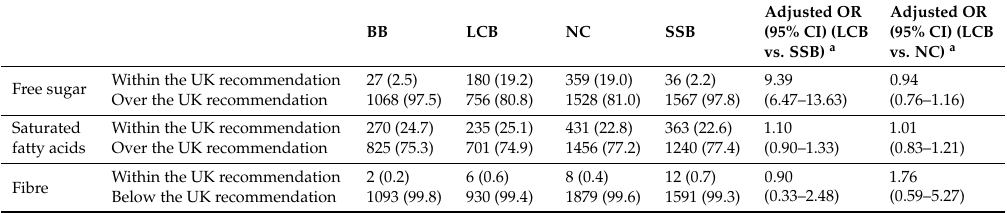
Table 3. UK recommendation on free sugars, saturated fatty acids and fibre intake according to type of beverage consumption.